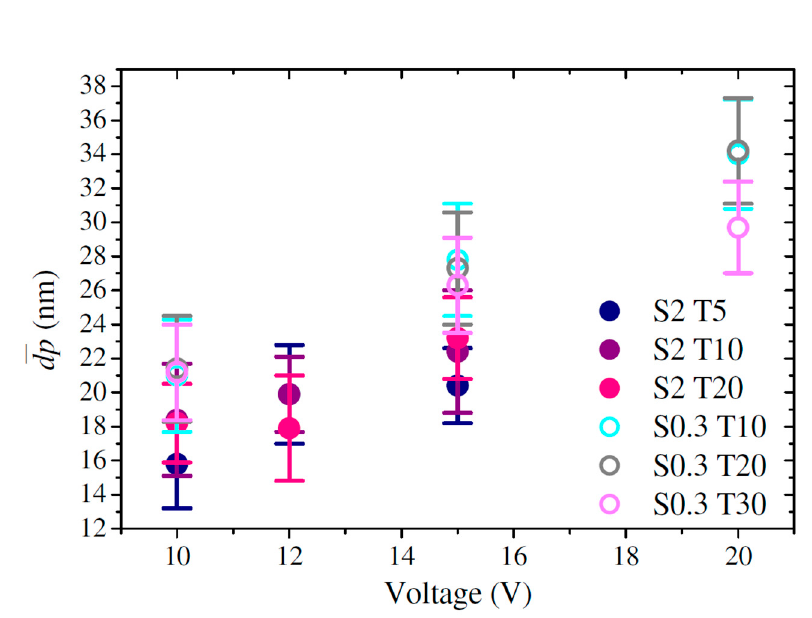
Figure 3. Variation of the average pore diameter of nanostructured aluminium oxide films anodized in sulphuric acid as a function of the concentration and temperature of the electrolyte and the voltage.